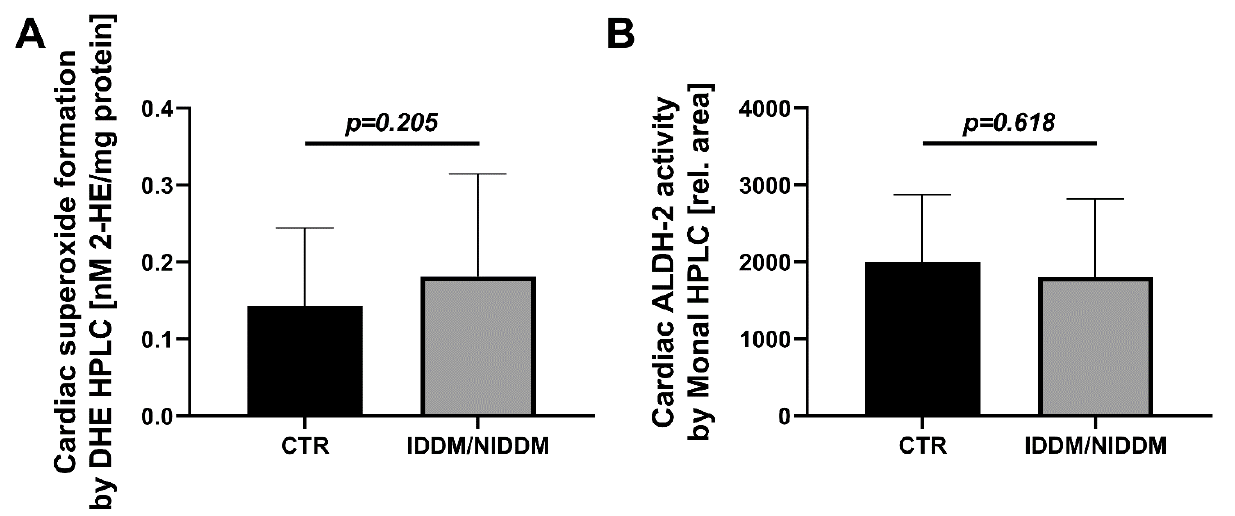
Figure 1. Markers of oxidative stress in myocardium. ( A ) Marginal higher concentration of mitochondrial superoxide formation (DHE HPLC) in the diabetic (IDDM/NIDDM) group versus control (CTR). ( B ) No difference in ALDH-2 activity after oxidative inactivation in the IDDM/NIDDM versus CTR group. 2-HE, 2-hydroxyethidium; ALDH-2, mitochondrial aldehyde dehydrogenase. Data are the mean ± SD of n = 38 (CTR) and 20 (IDDM/NIDDM) ( A ) and n = 16 (CTR) and 11 (IDDM/NIDDM) ( B ) patients. Mann–Whitney test in ( A ) and unpaired t -test in ( B ). CTR, control; IDDM, insulin-dependent diabetes mellitus type 2; NIDDM, non-insulin dependent diabetes mellitus type 2.